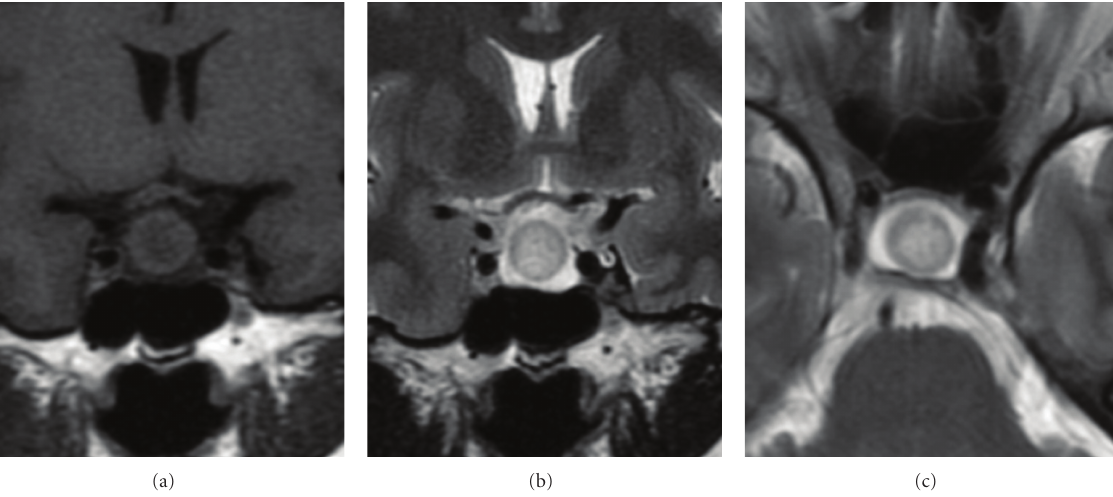
Figure 2: Case 10: nonenhanced MRI shows bull’s eyelike intracystic nodules in RCC. Cyst fluid with hypointense signal in T1-weighted images and hyperintense signal in T2-weighted images. Circular isointense signal in T1- and T2-weighted images surrounding the nodule, and slight hypointense signal in T1-weighted image and slight hyperintense signal in T2-weighted images at the center of cyst. (a) non- enhanced coronal T1-weighted image; (b) coronal T2-weighted image; (c) axial T2-weighted